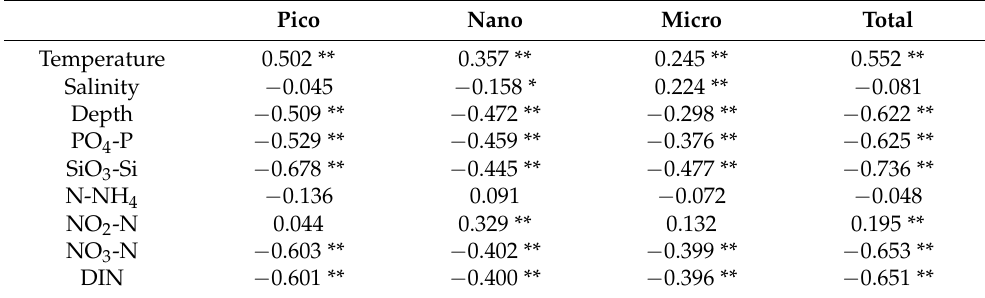
Table 3. Pearson’s rank correlation coefficients between environmental factors and concentrations of size-fractionated Chl a . The concentrations of size-fractionated Chl a were log transformed prior to analysis. * p < 0.05 (2-tailed); ** p < 0.01 (2-tailed). Pico Nano Micro Total Temperature 0.502 ** 0.357 ** 0.245 ** 0.552 ** Salinity − 0.045 − 0.158 * 0.224 ** − 0.081 Depth − 0.509 ** − 0.472 ** − 0.298 ** − 0.622 ** PO 4 -P − 0.529 ** − 0.459 ** − 0.376 ** − 0.625 ** SiO 3 -Si − 0.678 ** − 0.445 ** − 0.477 ** − 0.736 ** N-NH 4 − 0.136 0.091 − 0.072 − 0.048 NO 2 -N 0.044 0.329 ** 0.132 0.195 ** NO 3 -N − 0.603 ** − 0.402 ** − 0.399 ** − 0.653 ** DIN − 0.601 ** − 0.400 ** − 0.396 ** − 0.651